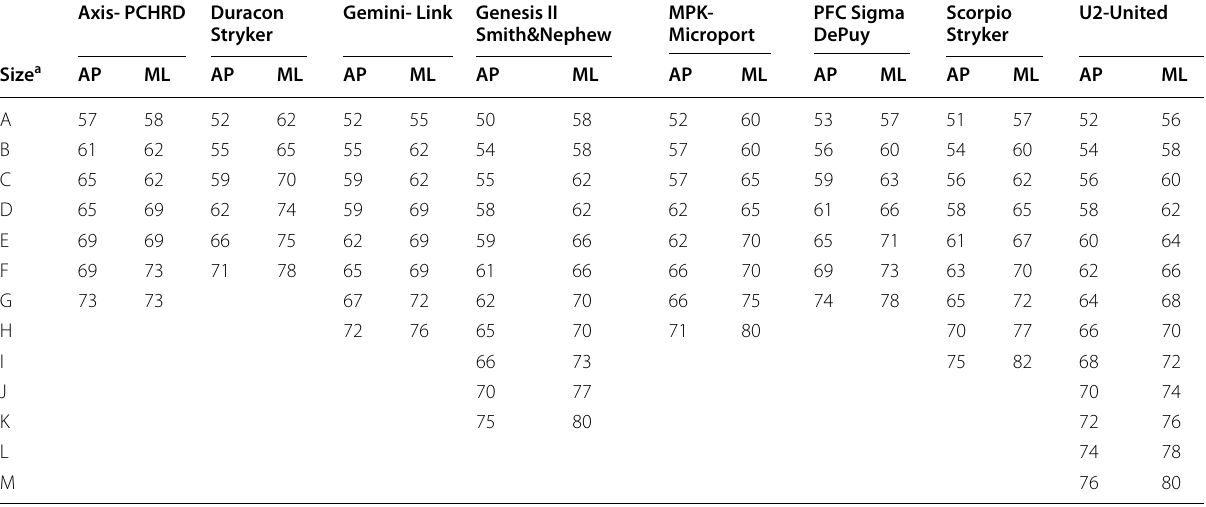
Table 7 Anteroposterior and mediolateral dimensions of the available TKR-tibial prostheses in the Philippine and Asian markets (in